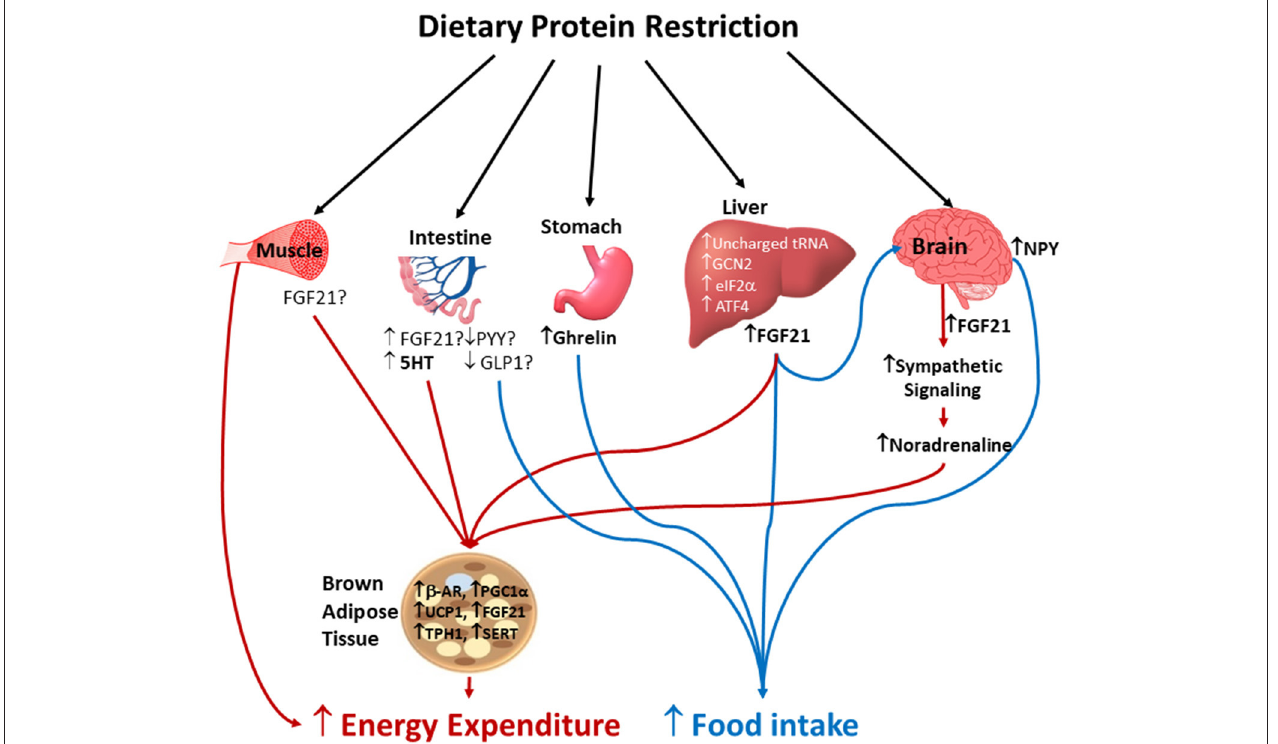
FIGURE 1 | Potential mechanisms by which protein dilution alters energy intake and energy expenditure. Protein restriction concurrently increases energy intake and energy expenditure. Amino acids insufficiency is sensed by liver, small intestine, and brain by the involvement of unchanged tRNA, non-derepressible (GCN2), eukaryotic translation initiation factor α (eIF2 α ) and activating transcription factor 4 (ATF4) which results in hyperphagia to restore protein balance. The low protein induced hyperphagia is possibly mediated by increased circulating concentrations of ghrelin and fibroblast growth factor-21 (FGF21), and neuropeptide Y (NPY) expression in the hypothalamus. Whether reduced secretion of anorexigenic gut peptides such as peptide YY (PYY) and glucagon-like peptide 1 (GLP-1) contribute to increased energy intake following protein dilution is not completely known. The increased energy expenditure in response to protein restriction is mediated by multiple mechanisms including increased sympathetic flux and upregulation of thermogenic markers in brown adipose tissue (BAT), and muscle thermogenesis. Whether local FGF21 secreted by skeletal muscle, small intestine and BAT, and 5-hydroxytryptamine (5HT) signaling in BAT play a role in low protein induced thermogenesis via autocrine, paracrine and endocrine pathways remains unclear. B-AR, beta adrenergic receptors; UCP1, uncoupling protein-1; PGC-1 α , proliferator-activated receptor gamma coactivator 1-alpha; TPH1, tryptophan hydroxylase 1; SERT, serotonin